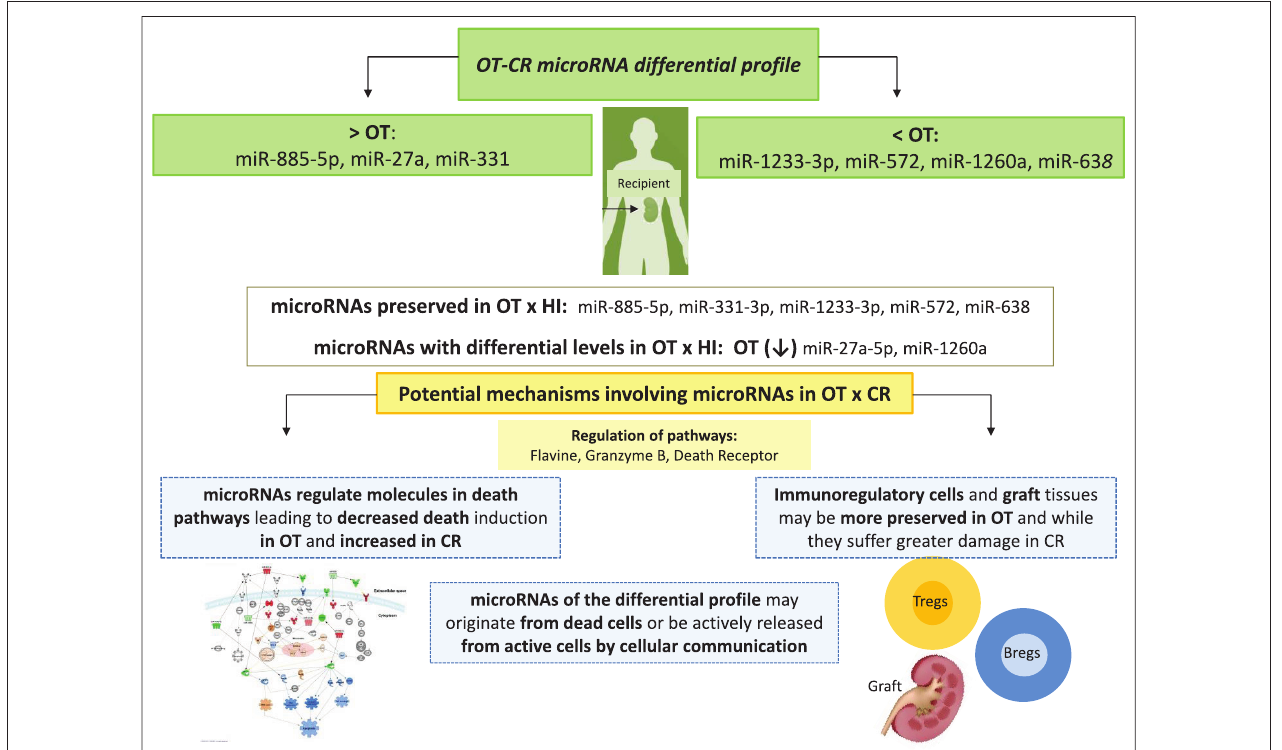
FIGURE 5 | Summary of our main findings and some hypotheses we have raised for potential mechanisms in OT, involving the microRNAs comprised in the OT-CR differential profile. At the top of the figure, we show the set of microRNAs comprised in the OT-CR differential profile indicating those presenting higher or lower levels in OT. Then, we indicate the microRNAs whose levels may be preserved in OT in relation the physiologic state, and those with decreased levels. Among the potential mechanisms of tolerance involving these microRNAs, we highlight the death receptor pathway. Our hypothesis is that OT may also involve mechanisms mediated by microRNAs affecting the cell death pathway. These mechanisms would favor the survival of cells most likely with the regulatory profile, as well as of graft tissue, contrary to what is could be occurring in CR. Understanding these mechanisms may contribute to the development of novel strategies to promote cell survival in renal transplantation, favoring the development of transplantation tolerance, in the